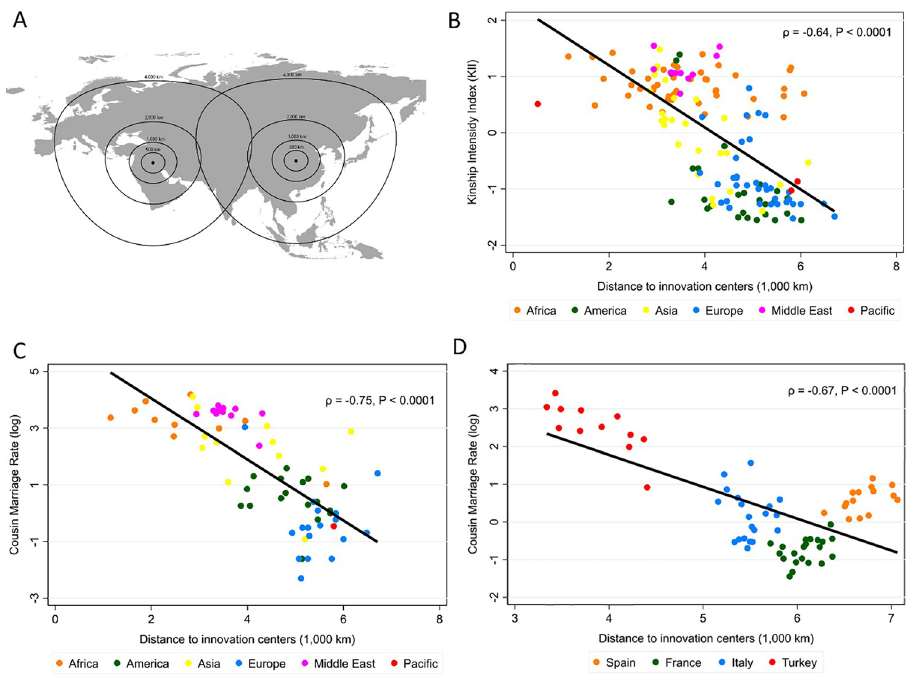
Fig 1. Distance to innovation and kinship intensity. Notes: Example scheme of the diffusion of kinship innovations through the case of Eurasia ( A ). Relationships between average Distance to innovation and Kinship Intensity Index and Cousin marriage rate worldwide ( B and C ) and Cousin marriage rate in regions of four European countries ( D ). The base map in Fig 1A is from IDRE [24] under an Open Data License.